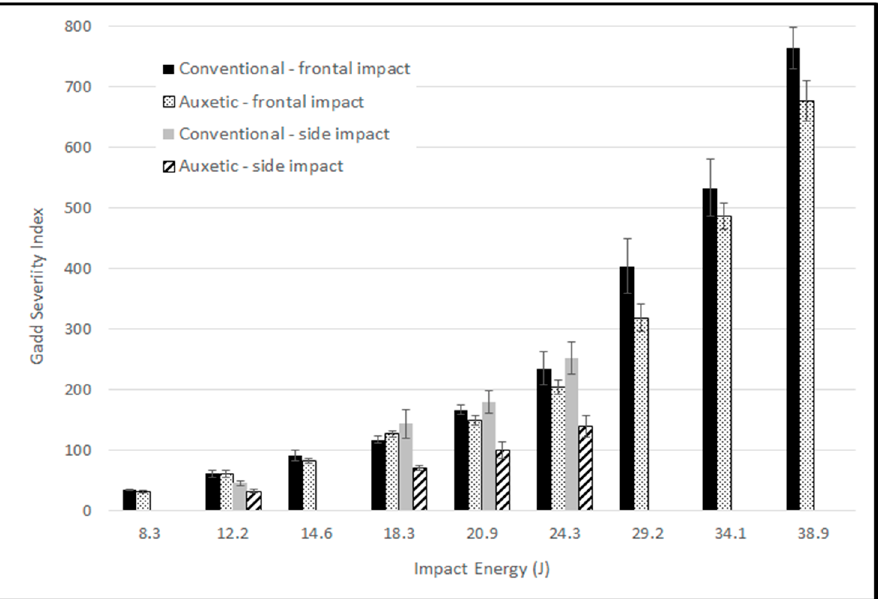
Figure 5. Helmet drop test severity for the different impact energies, showing both the frontal impact and side impacts (error bars ±1 s.d.).